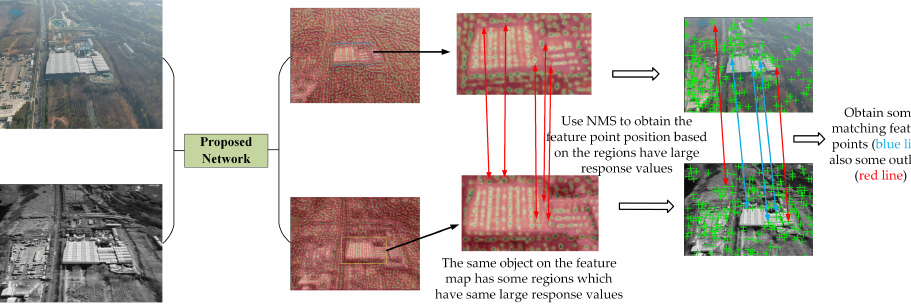
Figure 6. For one given input image pair, we show the pipeline of the valid local features ob- tained